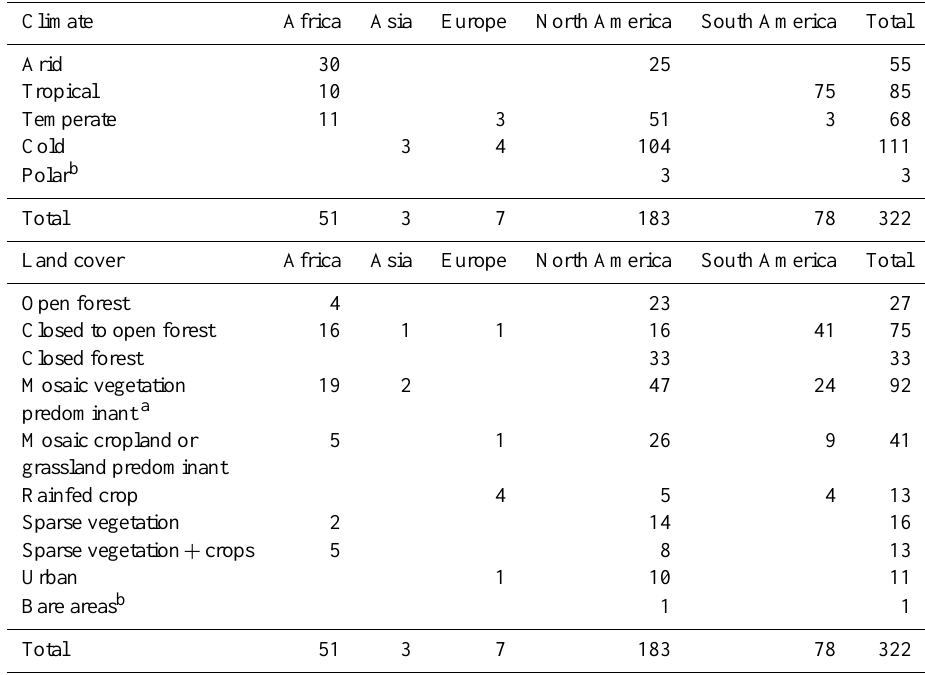
Table 2. Climate and land cover type of the 322 sites selected for the calibration and validation, aggregated by continent, climate and land